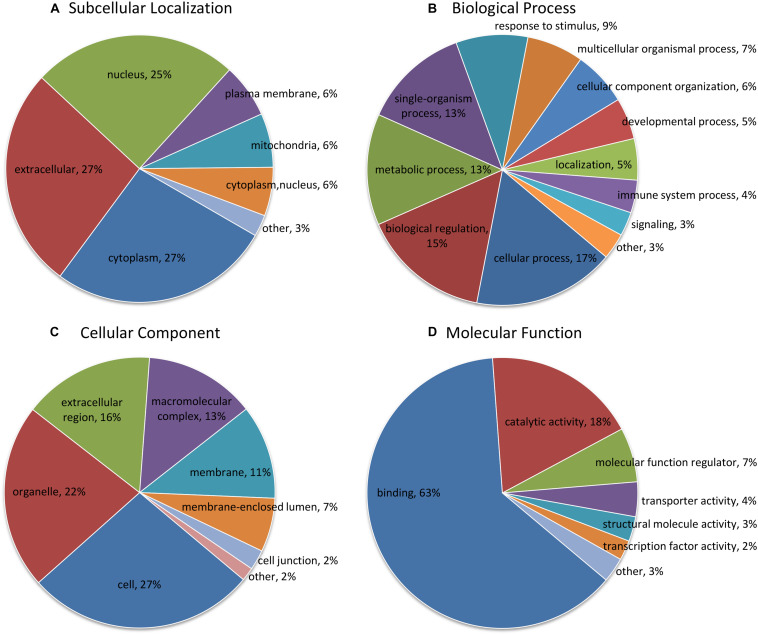
Functional classification analysis of differentially expressed proteins (DEPs). (A) Subcellular localization prediction; (B) Gene Ontology (GO) classification in terms of biological process; (C) GO classification in terms of cellular component; (D) GO classification in terms of molecular function. The term and proportion of DEPs are shown in each sector.